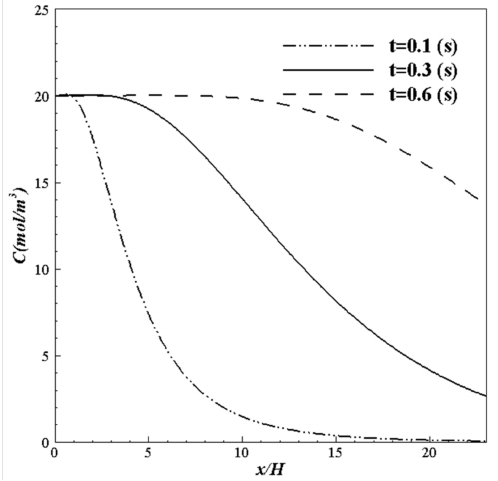
Figure 14. The variation in concentration versus the length to height ratio of the porous collector for the three different times, with a high porosity coefficient of 0.8.